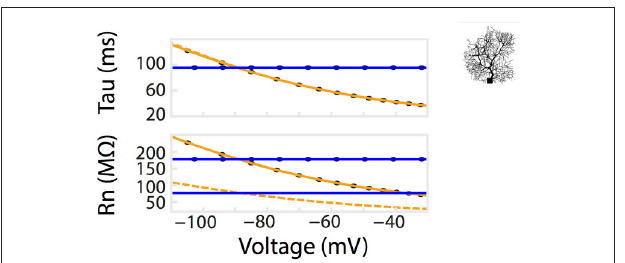
FIGURE 4 | Dendritic branching of neurons exaggerates the non-linear relationship of R n -voltage. A comparison of R n /tau –voltage relationships was calculated from a multi-compartmental model with the same surface area as the isopotential model in Figure 2 . Voltage responses of the model to a series of current pulses, as in Figure 2A . Corresponding values from simulation using the isopotential model are represented by dotted lines. Ohmic simulation results are shown in blue.